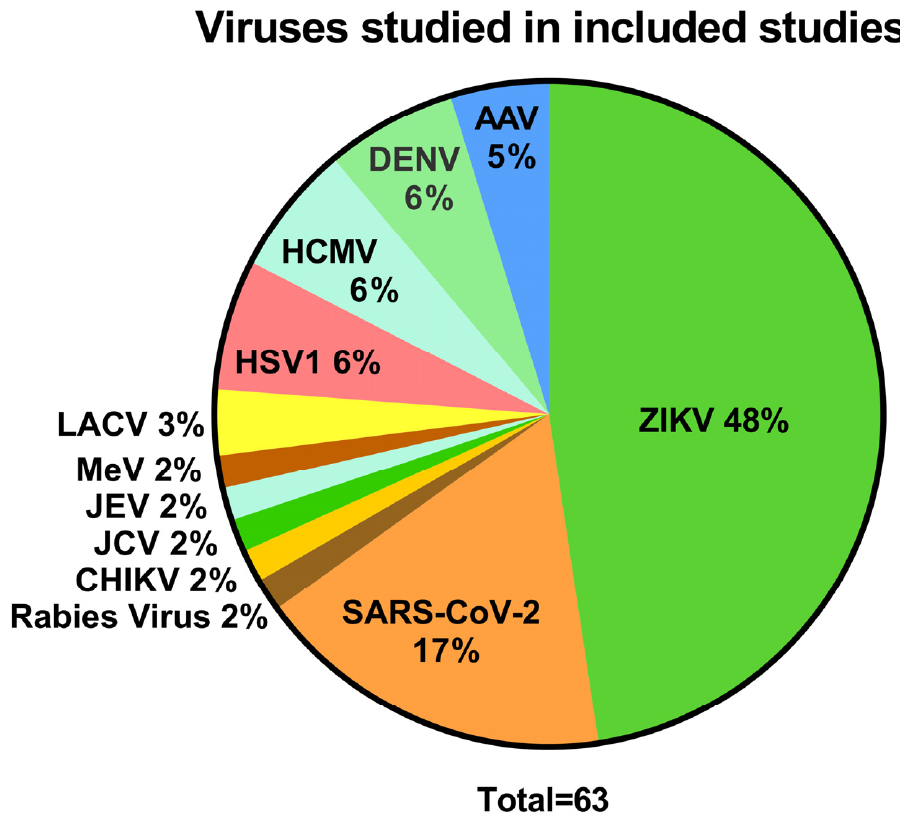
Figure 2. The variety of viruses studied. (Zika virus (ZIKV), severe acute respiratory syndrome coronavirus 2 (SARS-CoV-2), John Cunningham virus (JCV), Chikungunya virus (CHIKV), herpes simplex virus (HSV), human cytomegalovirus (HCMV), dengue virus (DENV), adeno associated virus (AAV), measles virus (MeV), Rabies virus, Japanese encephalitis virus (JEV), and lacrosse virus (LACV)) using human brain organoids. The total number of studies exceeded the number of included papers, as some papers reported on multiple viruses.